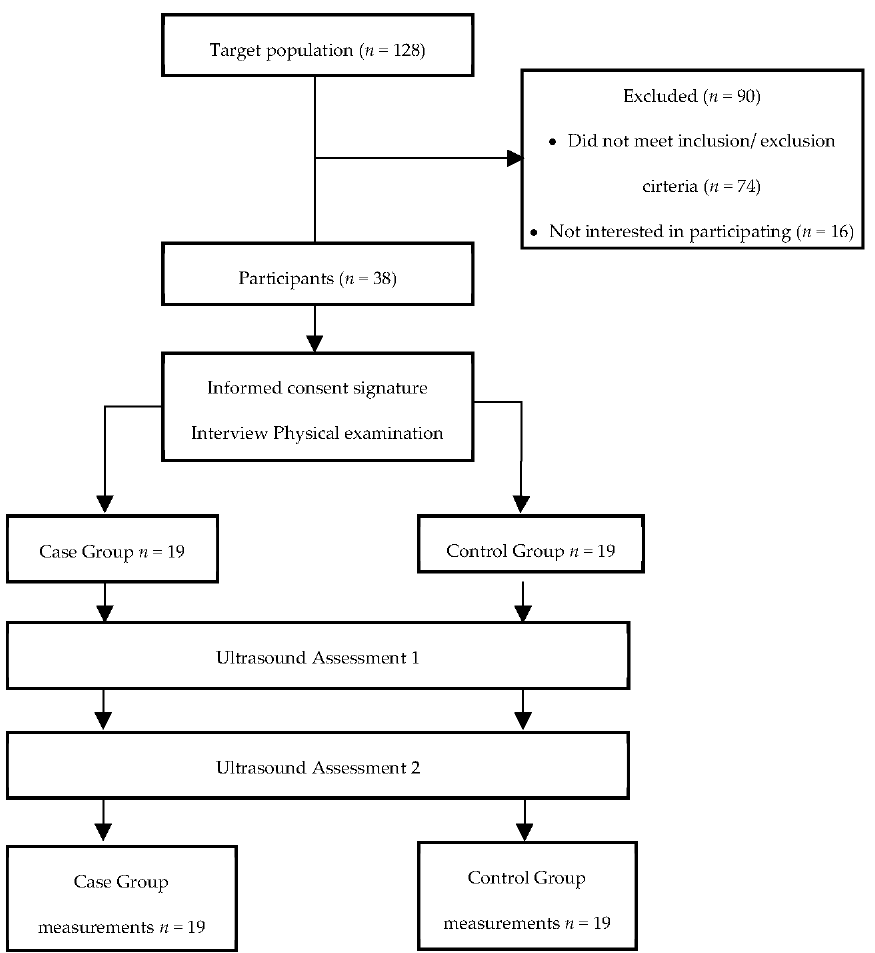
Figure 3. Flow chart diagram.